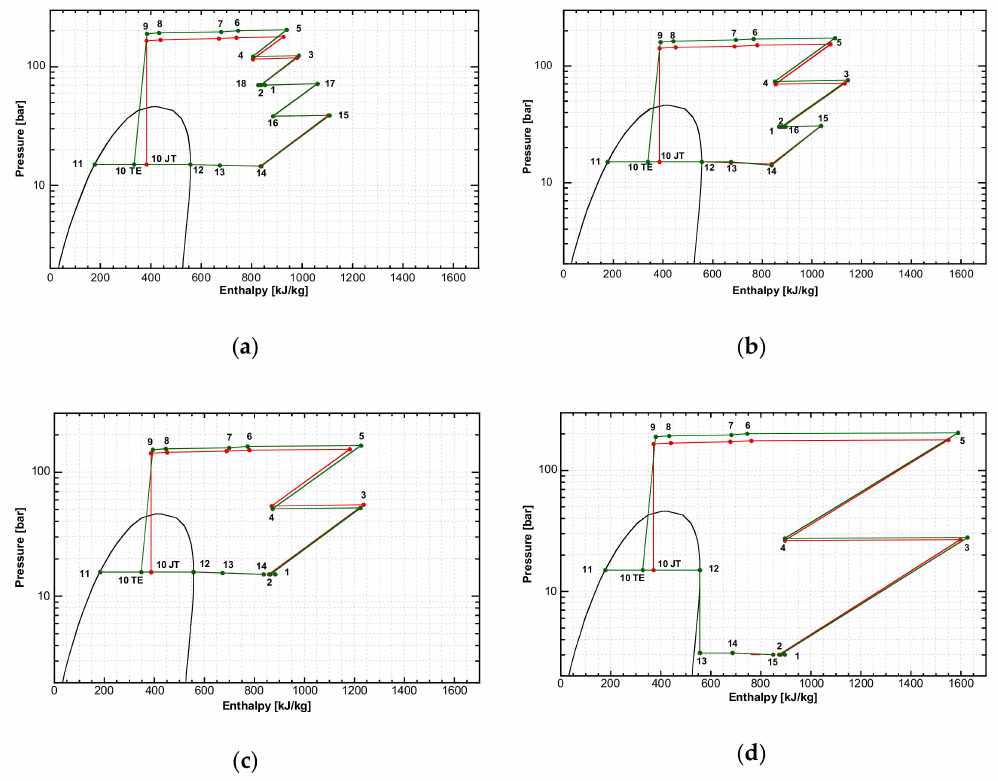
Figure 4. Optimum thermodynamic cycles in pressure-enthalpy diagram: ( a ) HPN, ( b ) MHPN, ( c ) MLPN, ( d )